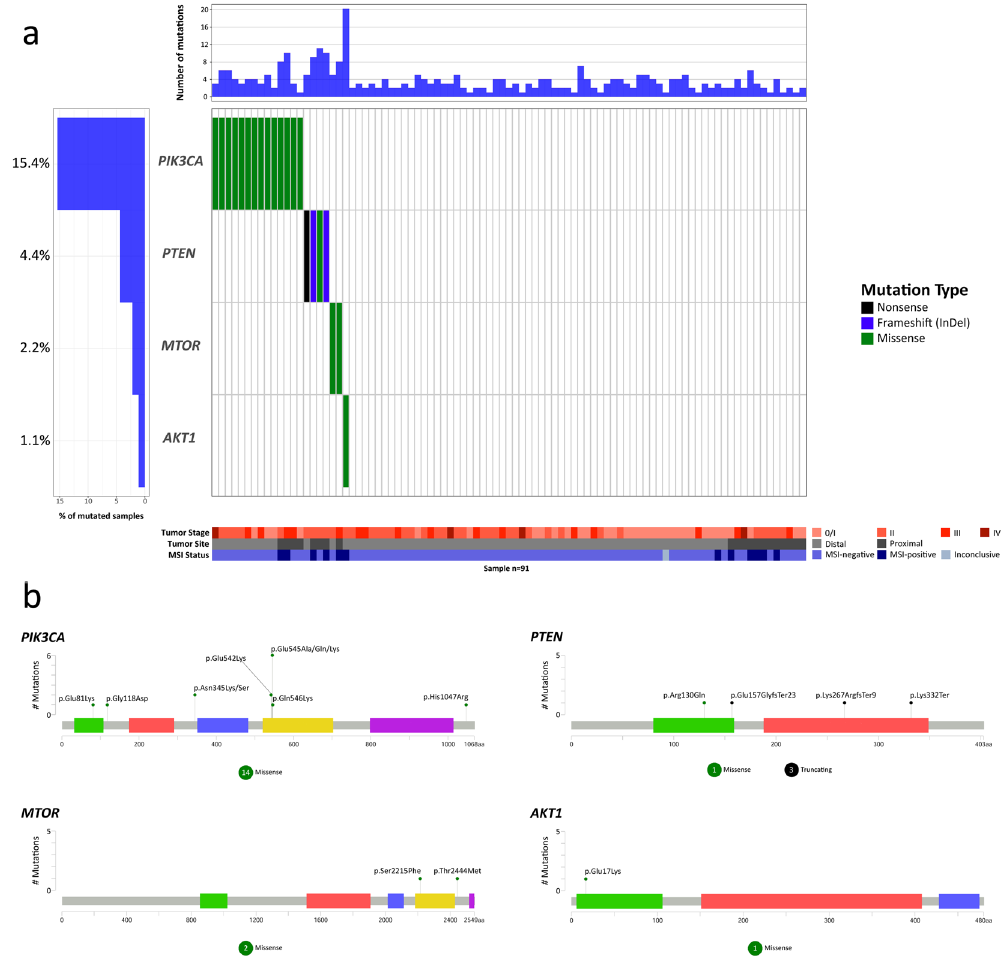
Figure 3. Waterfall (oncoplot) plot ( a ) and mutation mapper ( b ) of PI3K-AKT signaling pathway genes. Tumor stage: stage of the disease at diagnosis. MSI: microsatellite